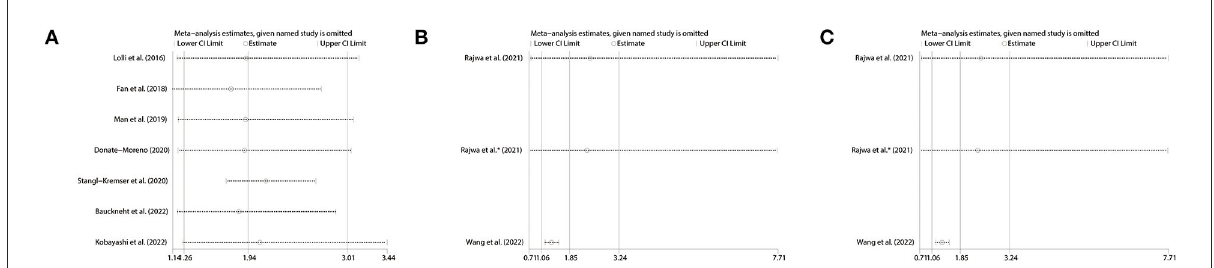
FIGURE7 Sensitivity analysis of pooled results for (A) OS, (B) PFS in mCRPC patients and (C) BFS in nmPCa patients. OS, overall survival; PFS, progression-free survival; BFS, biochemical recurrence-free survival; mCRPC, metastatic castration-resistant prostate cancer; nmPCa, non-metastatic prostate